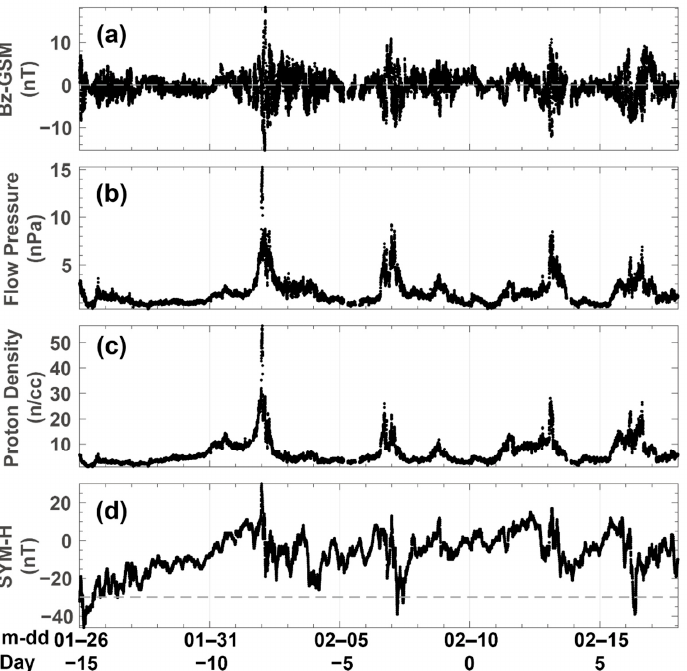
Figure 2. Solar wind parameters and SYM-H indices from 26 January to 17 February 2021, i.e., 15 days before to 7 days after the M7.7 earthquake. ( a ) IMF Bz in the GSM coordinate system, and the gray dashed line indicates Bz = 0; ( b ) the solar wind dynamic pressure; ( c ) the solar wind proton density; and ( d ) the SYM-H index. The gray dashed line indicates − 30 nT. Figure 3a presents the remaining Swarm B orbits (LT~17) with magnetic disturbances in Br and Ba components after the above analysis, and Figure 3b–e show comparisons of these magnetic disturbances with the simultaneously measured electron density (Ne). There are no distinct perturbations in either the original or residual Ne.